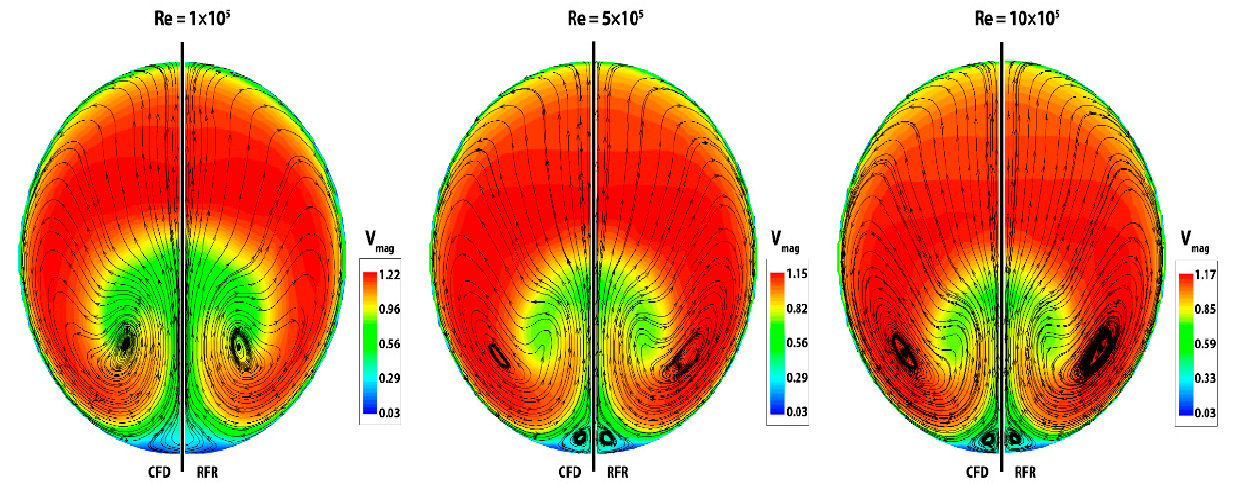
Figure 8. Flow structure at bend outlet ( θ = 90 ◦ ) of the bend for different Re. ( left section : CFD result; right section : RFR result).